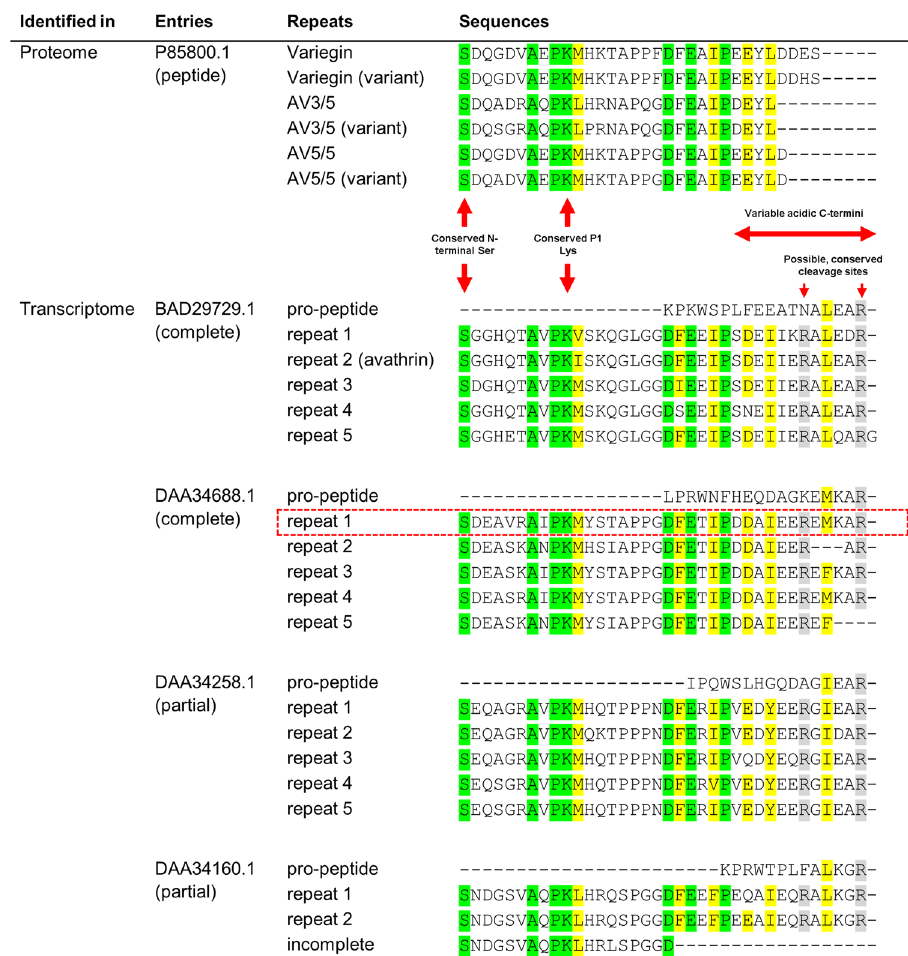
Fig. 1 Thrombin-inhibiting peptides from A. variegatum . Precursor transcripts are indicated by GenBank accession numbers. Each row within the transcripts represent repeats that may be processed into mature thrombin-inhibiting peptides. Identical and highly similar amino acid residues were highlighted in green and yellow, respectively. Potential cleavage sites are highlighted in grey. The sequence representative of repeat 1 of DAA34688.1 (red dotted box) was synthesised for